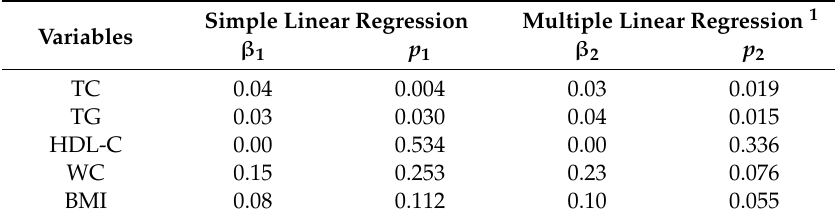
Table 2. Linear regression analysis of the relationship between leisure-time sedentary duration (LTSD) and TC, TG, HDL-C, WC, and